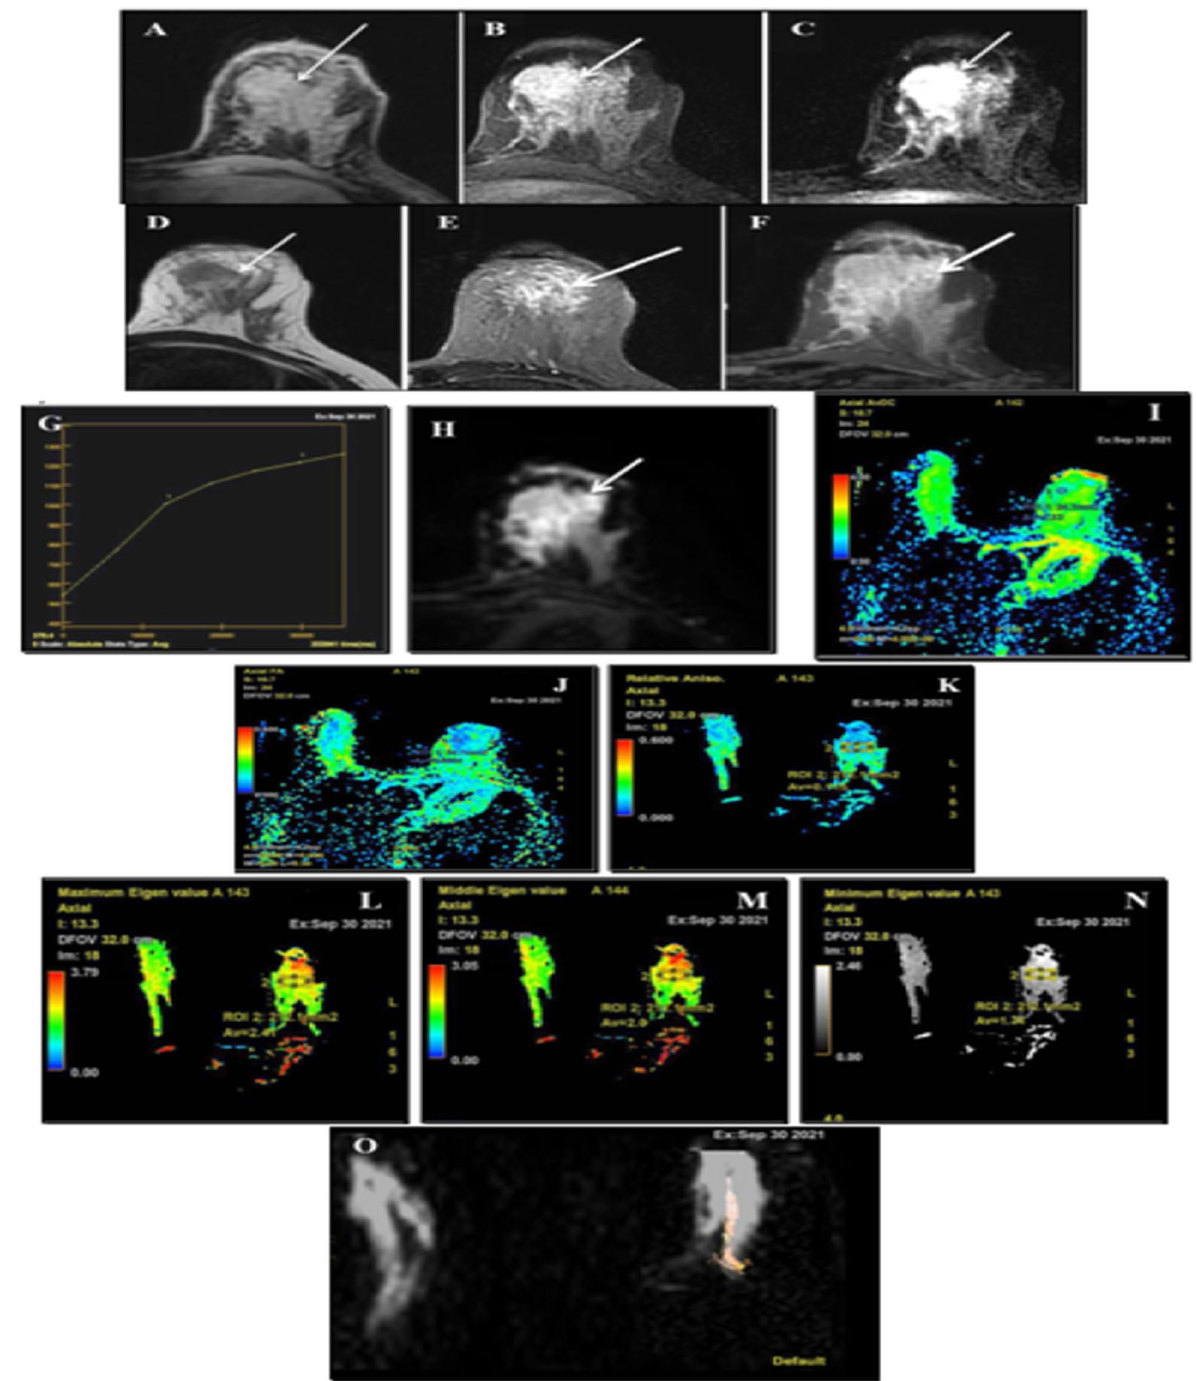
Fig. 3 a Axial T1WI FAT SAT pre‑contrast: The mass displays isointense signal, b Axial T1WI post‑contrast, c Post‑subtraction images: Homogenous non‑mass enhancement, d Axial T2WI: Low signal intensity, e Axial T2WI FS: The mass displays high signal intensity (no suppression), f Axial STIR: The mass displays high signal intensity, g kinetic curve: Type I, rising curve, h Axial DWI: The mass displays high signal, i ADC value mm 2 /s (cut‑off value of < 1.21 10 − 3 mm 2 /s), j FA 0.09 (cut‑off value of > 0.15), k RA 0.11 (cut‑off value of > 0.13), l Maximum eigenvalue × = = ( λ 1) 2.4 10 − 3 mm 2 /s (cut‑off value of < 1.71 10 − 3 mm 2 /s), m : Middle eigenvalue ( λ 2) 2 10 − 3 mm 2 /s (cut‑ off value of < 1.31 = × × = × n Minimum eigenvalue ( λ 3) 1.34 10 − 3 mm 2 /s (cut‑ off value of < 1.19 10 − 3 mm 2 /s) and o Fiber Tractography: Intact fibers suggesting benign = × × nature of the mass. Provisional diagnosis by DCE‑MRI and DTI parameters: Benign lesion. Histopathological diagnosis: Chronic